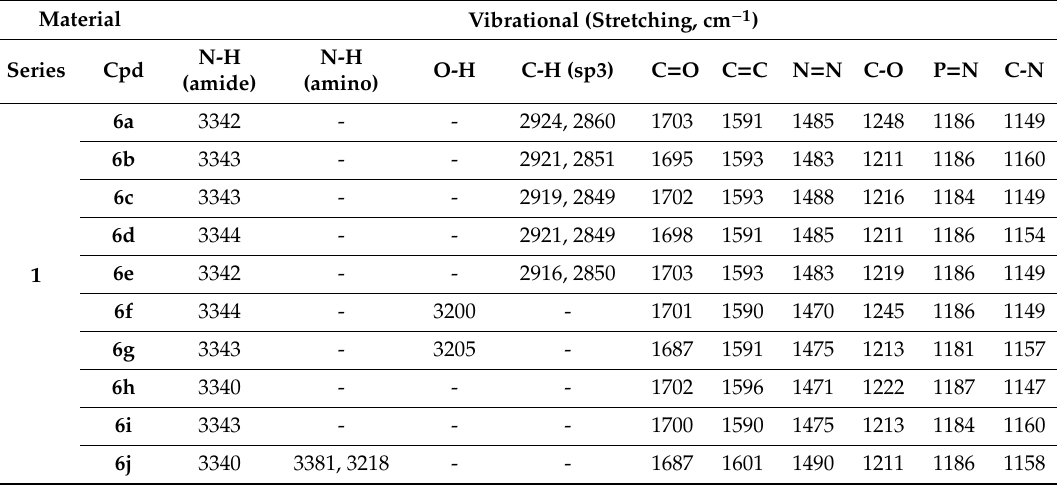
Table 1. FTIR data of compounds 6a–j (Series 1) and 8a–j (Series